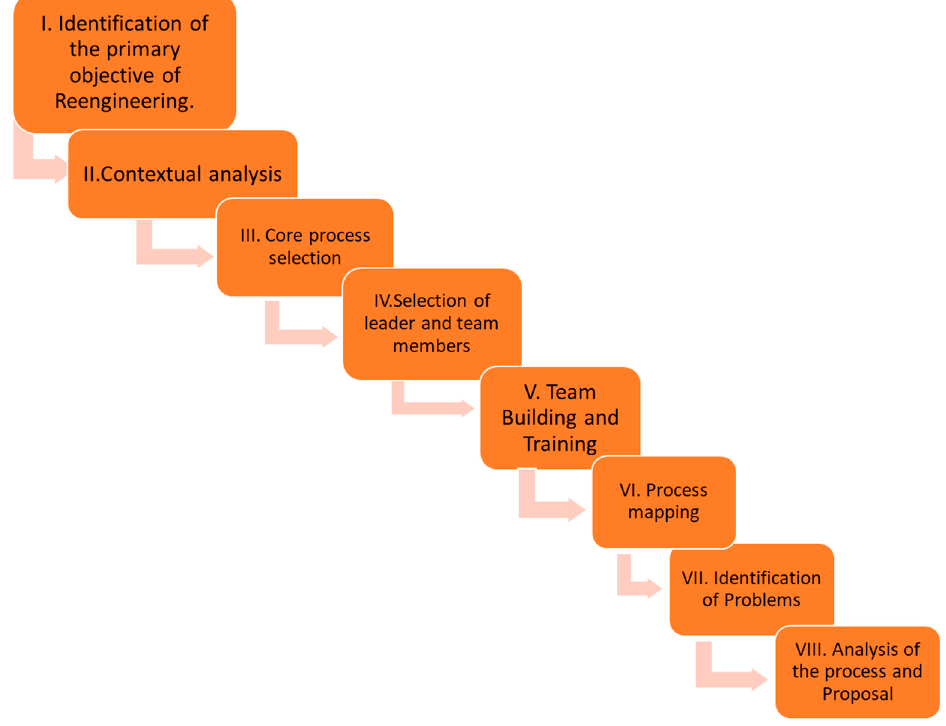
Figure 1. Reengineering methodology elaborated by the author.